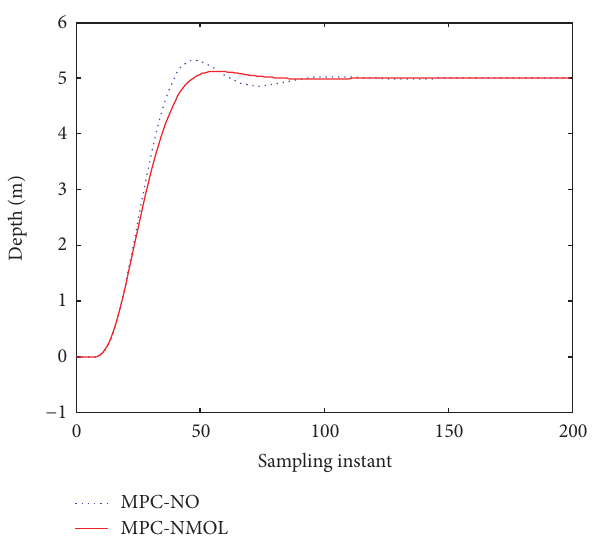
Figure 7: Comparison of depth with disturbance.